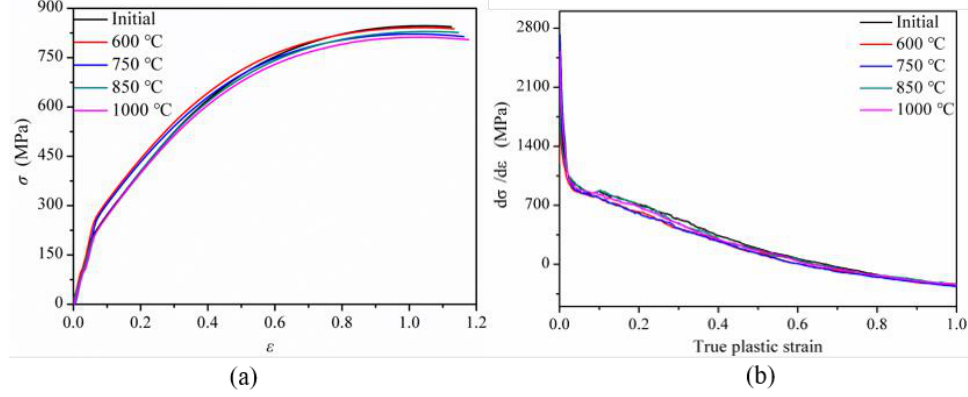
Figure 10. Stress-strain curves ( a ) and the corresponding strain hardening rates ( b ) of FeNiCoCr HEAs annealed at different temperatures.